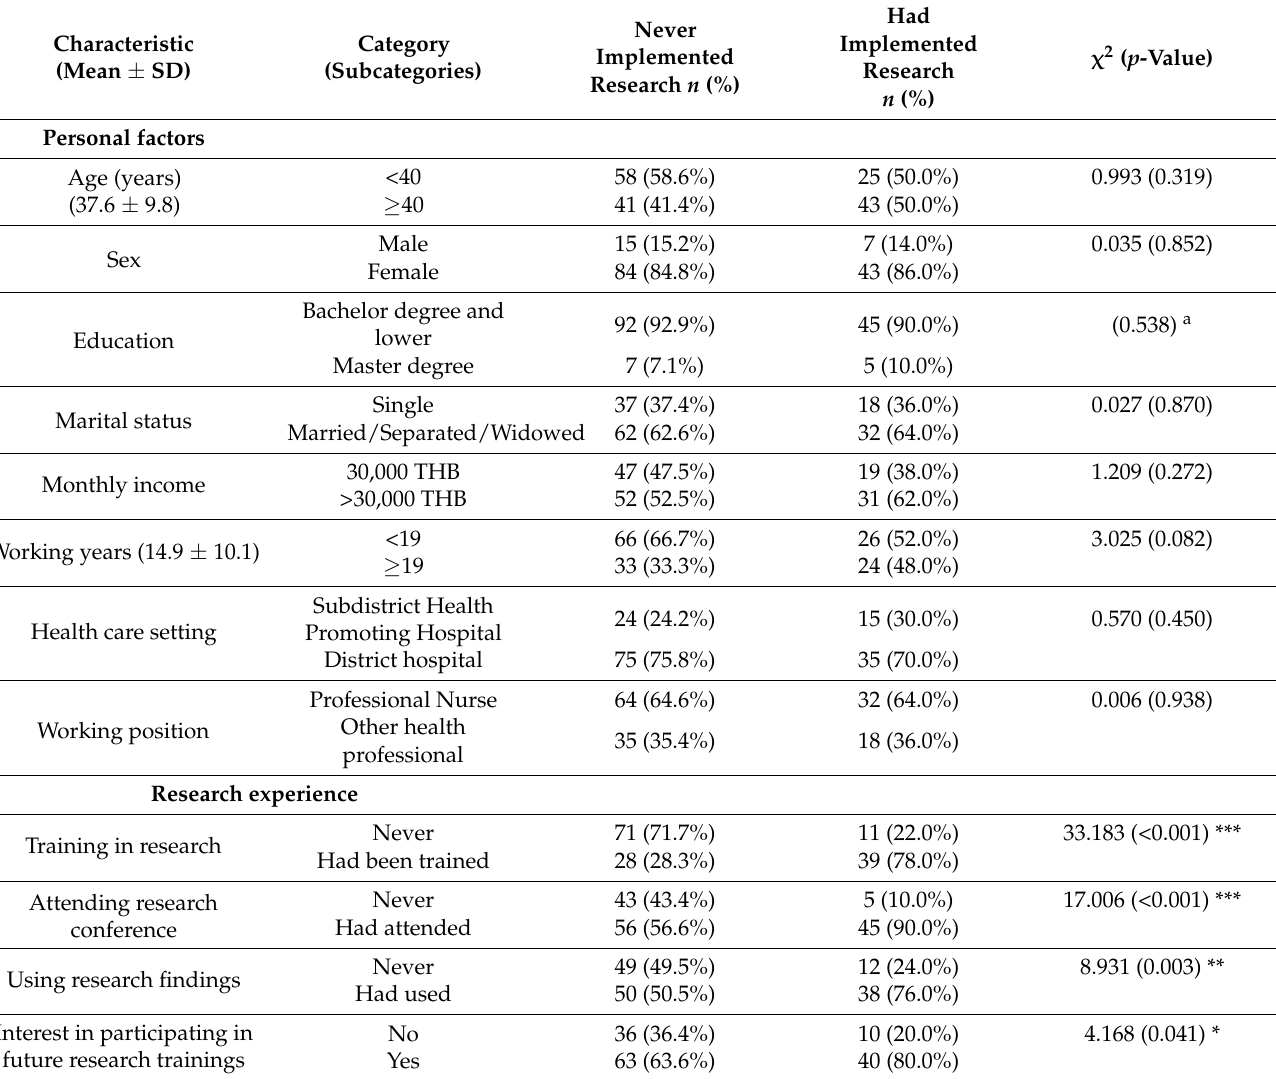
Table 3. Associations between personal factors, research experiences, and research implementation ( n = 149).